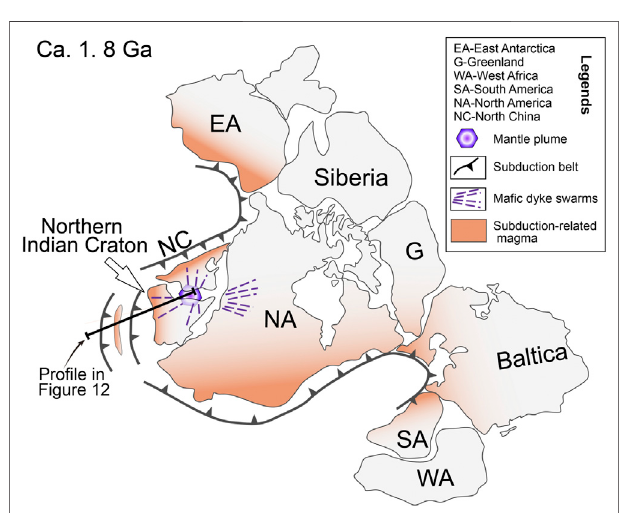
FIGURE 13 | An updated model for the ca. 1.8 Ga reconstruction of the supercontinent Columbia, modi fi ed from the study by Hou et al. (2008). In the modi fi edmodel,thereexistedatwo-arcsystemwithdoublesubductionzones in the northern margin of the northern Indian Craton, and the approximate position of the pro fi les in Figure 12 is